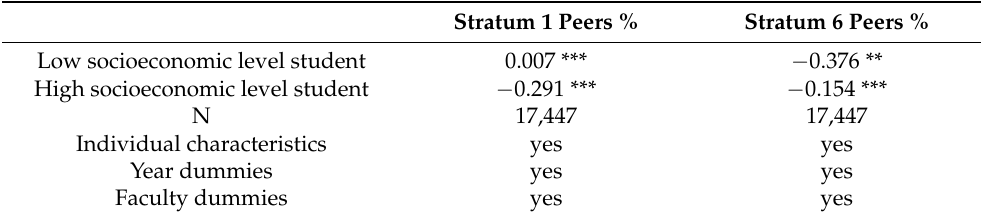
Table 8. Effects of heterogeneous peers according to student’s socioeconomic level in Communication Skills